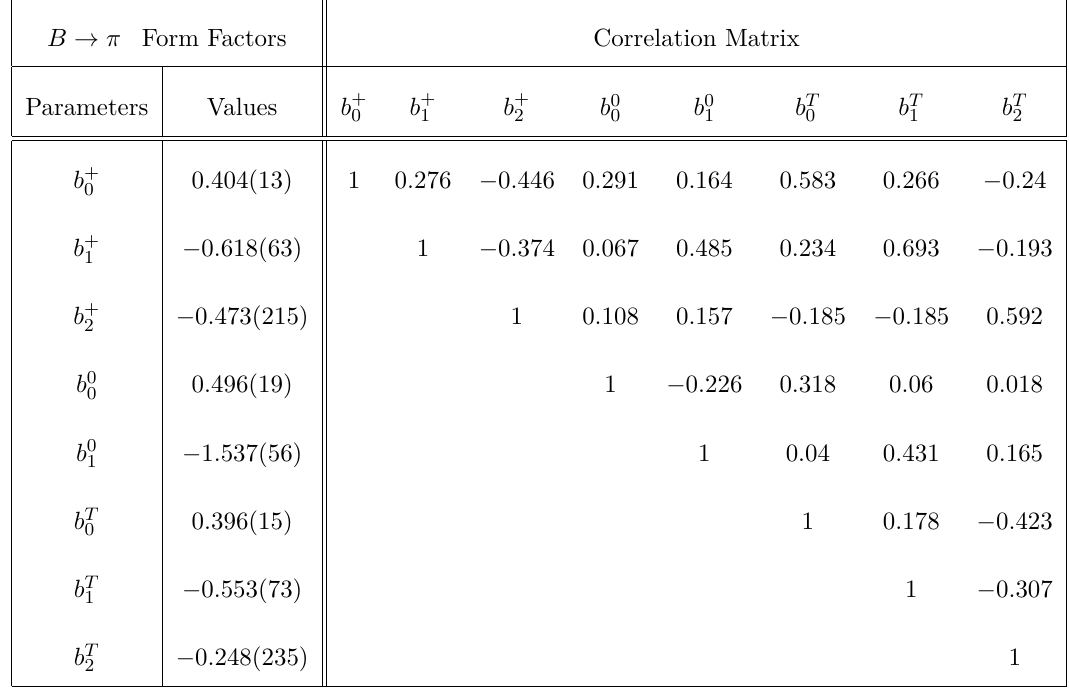
Table 2 . Theory predictions for the correlated z -series coefficients in the vector, scalar and tensor B → π form factors determined by fitting the BGL parametrization simultaneously against our LCSR results including a variety of the subleading-power corrections and the available lattice QCD data points from [3, 4, 7] with the preferred truncation N = 3